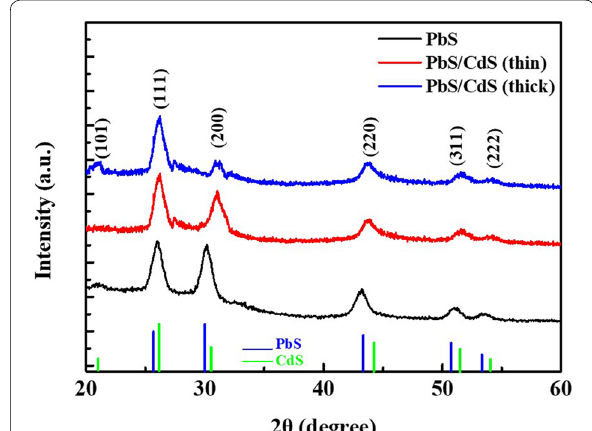
Fig. 2 XRD patterns of PbS, PbS/CdS (thin shell), and PbS/CdS (thick shell) QDs. The JCPDS card files (05‑0592, blue line) for PbS and (01 089 0440, green line) for CdS are shown below the spectra for